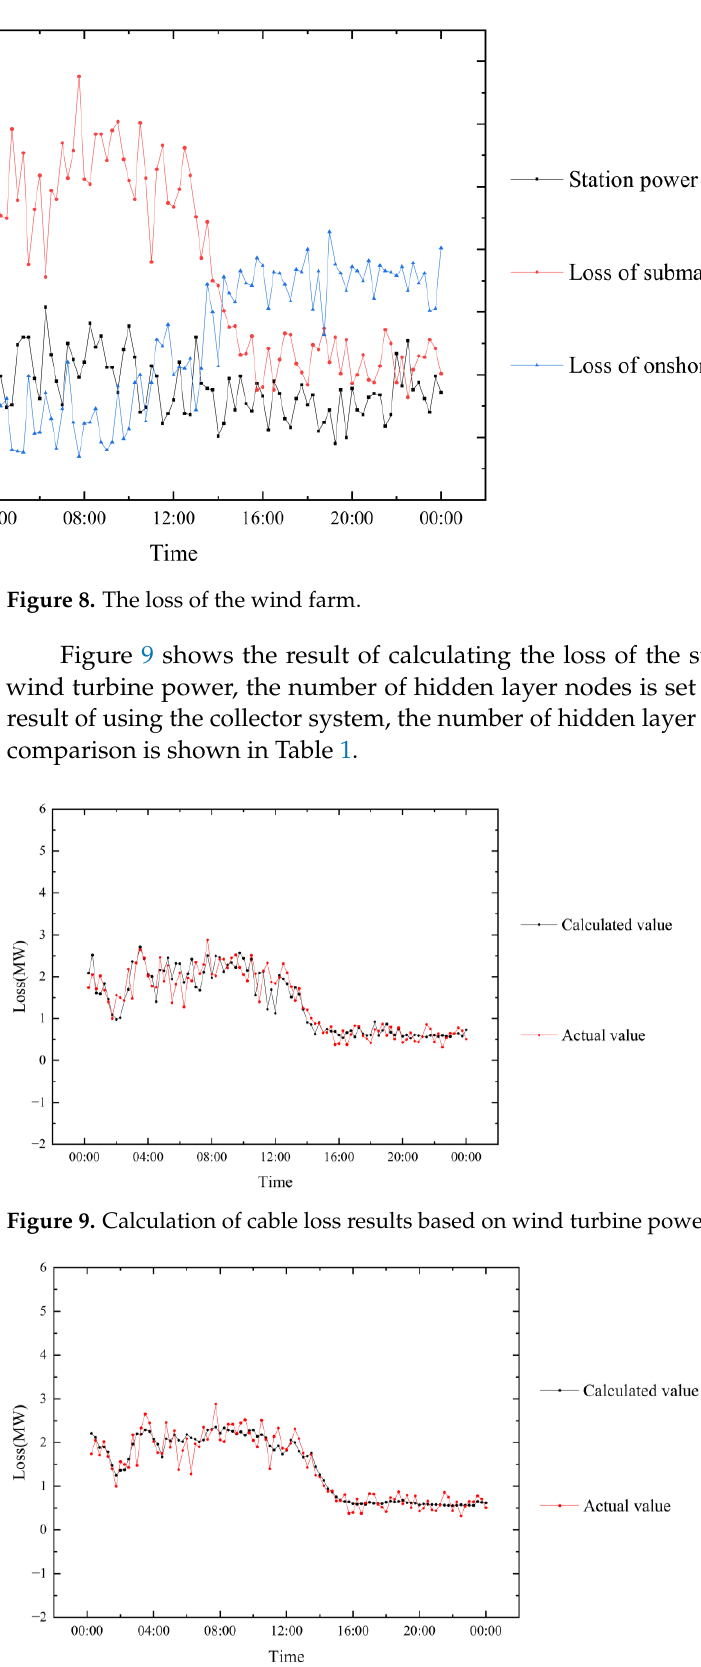
Figure 8. The loss of the wind farm.